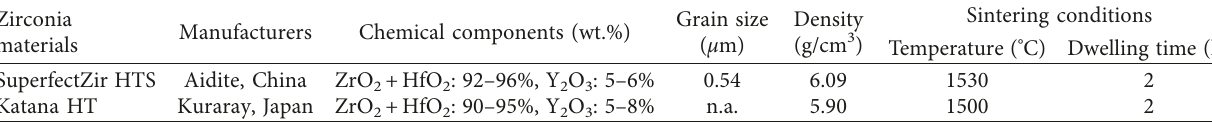
Table 1: Characteristics of the materials used in the present